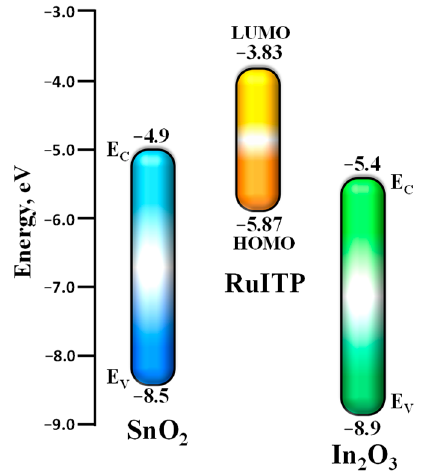
Figure 13. Scheme of the mutual arrangement of the energy levels for bulk SnO 2 , In 2 O 3 , HOMO, and LUMO of the RuITP complex.